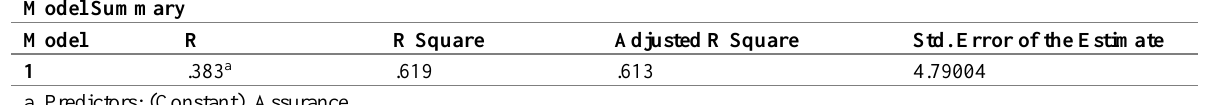
Table 12: Regression Analysis Relationship between Assurance and Customer Satisfaction